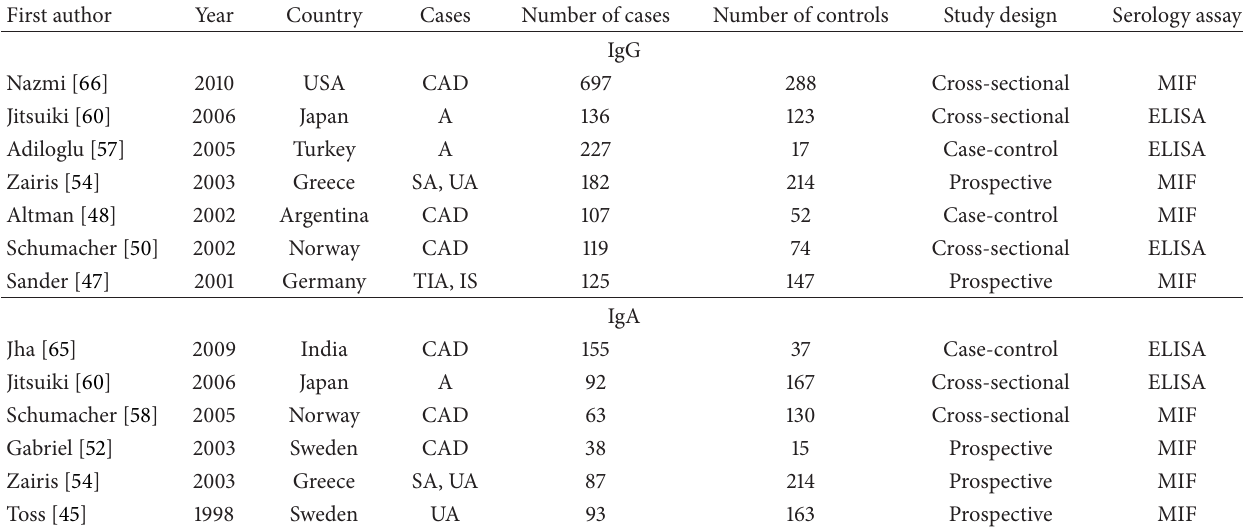
Table 2: Characteristics of the studies included in the C. pneumoniae IgG and IgA